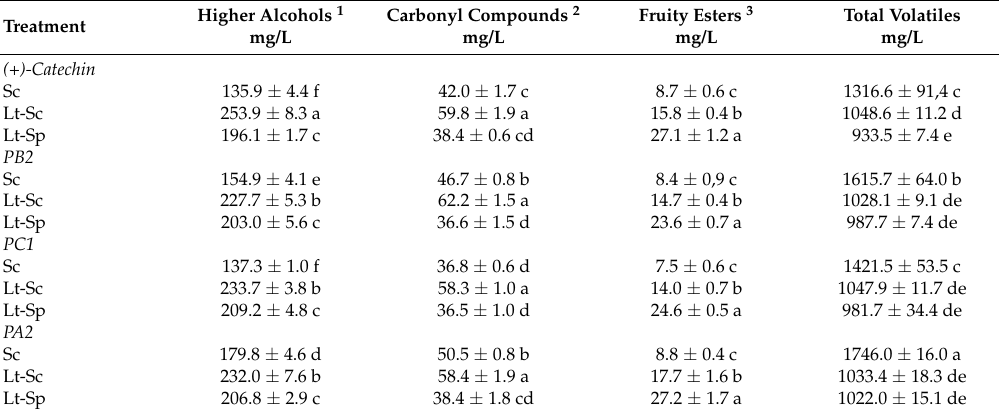
Table 2. Summary of fermentative volatile compounds quantified by GC-FID. The statistical analysis is given by parameter (columns) and the difference in letters indicates significant statistical difference (LSD method with 95% confidence level). Means ± STD ( n =